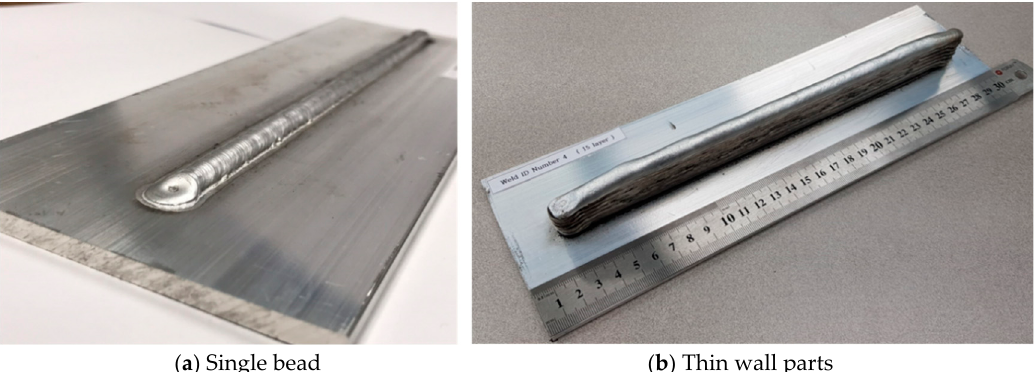
Figure 2. Schematic diagram of MIG-based AM systems for Al alloy.